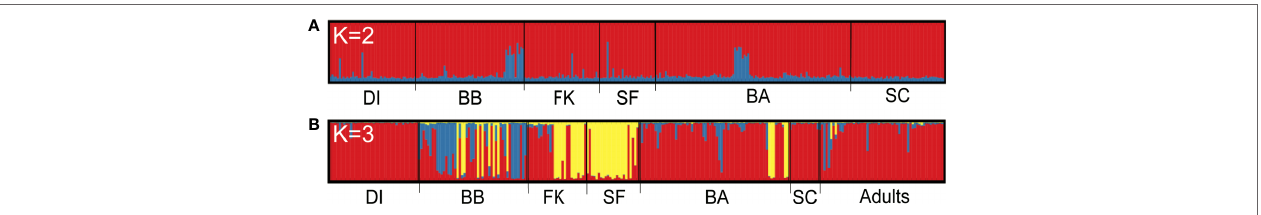
FIGURE 1 | Assignment bar plots showing the effect of partitioning samples by size. Each vertical bar represents an individual, grouped by catch location and shaded by proportion of population ancestry from Structure. (A) All unrelated individuals; (B) All non-dispersive individuals <260 cm, with adults ≥300 cm TL separated into their own group with no location. K, number of unique genetic clusters or populations identified across the sampling range; DI, Dauphin Island; BB, Big Bend, Florida; FK, Florida Keys; SF, South Florida; BA, Bahamas; SC, South